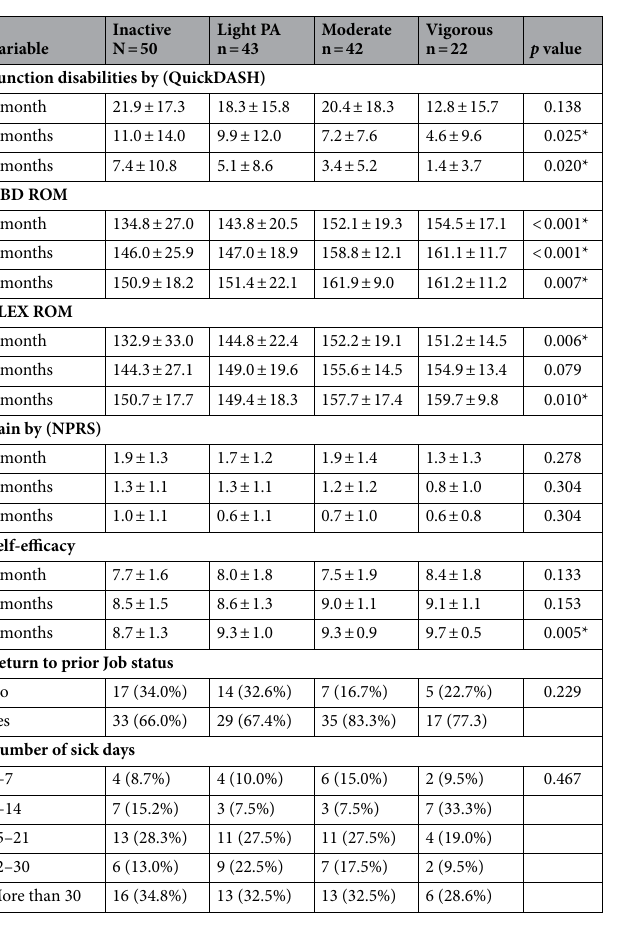
Table 2. The effect of the physical activity intensity on function, ROM, pain, self-efficacy, job status and sick days classified by intensity levels. Continuous variables are presented as mean and standard deviation (SD) and categorical variables are presented as number and percentage. Significant p value* p ≤ 0.05. PA, Physical activity; ABD, Abduction; FLEX, Flexion; ROM, Range of motion; NPRS, Numeric pain rating